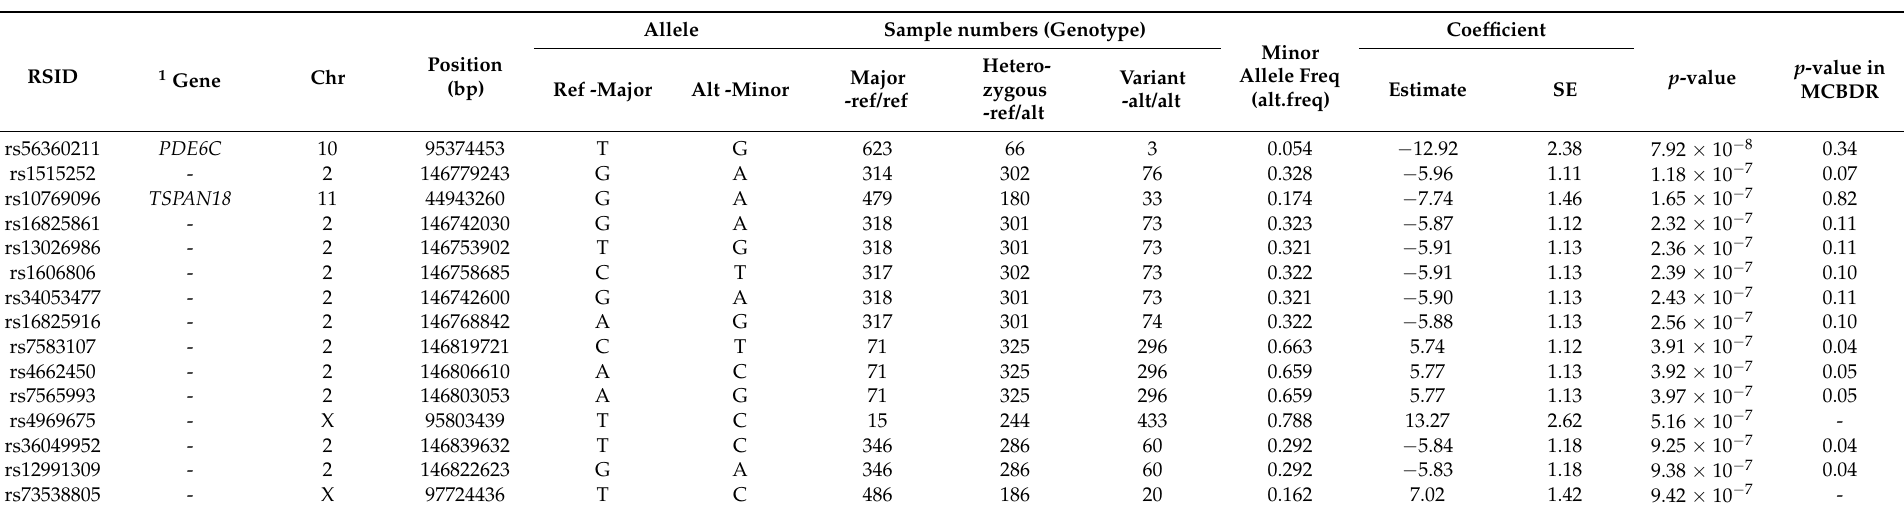
Table 5. SNPs with p -value < 1 × 10 − 6 associated with change in CIPN20 sensory in the N08Cx study